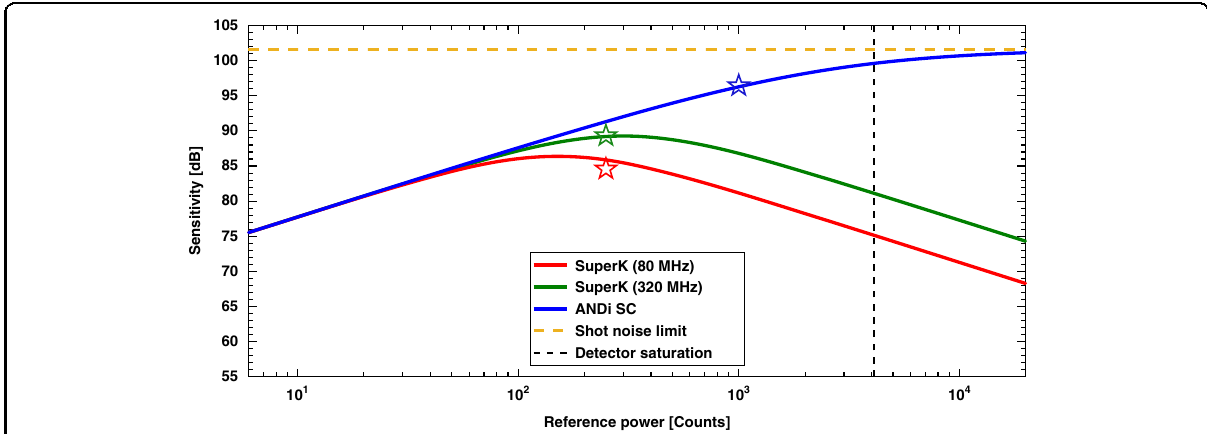
Fig. 5 OCT sensitivity. Theoretical sensitivity as a function of reference power for the 80 MHz SuperK extreme, 320 MHz SuperK extreme, and ANDi SC sources. Stars represent the experimentally obtained sensitivities presented in the materials and methods section. Model parameters are found from experimental system characterization and are given in detail also in the materials and methods section. Calculations are based on refs.